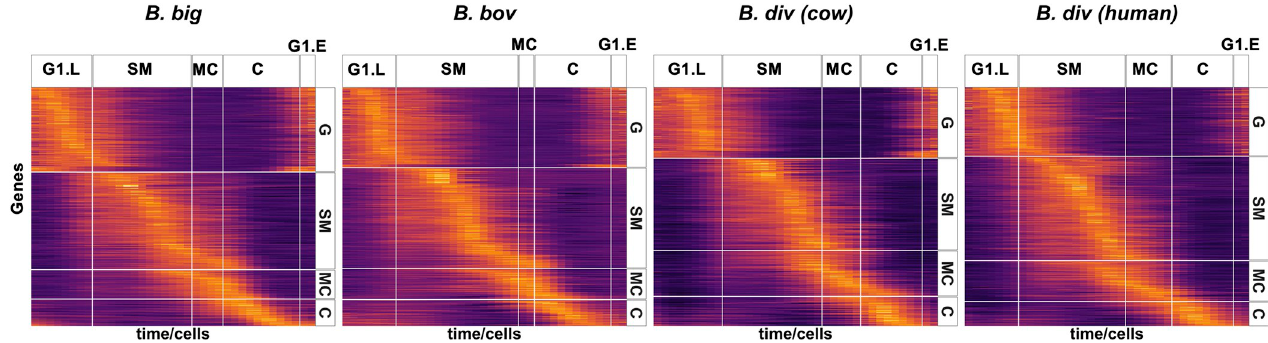
Fig 5. Transcription profile of replication cycle regulated genes: Heatmap of mean expression curves of differentially expressed genes of inferred replication cycle phases. Rows represent genes and columns represent pseudo-time-ordered cells. Horizontal facets group genes in the indicated phase. Vertical facets mark the transition time points. Analysis is done in each species independently (Fig 4A). Rows are ordered according to peak expression time. Data and code for generating the figure are available at https://github.com/umbibio/scBabesiaAtlases.